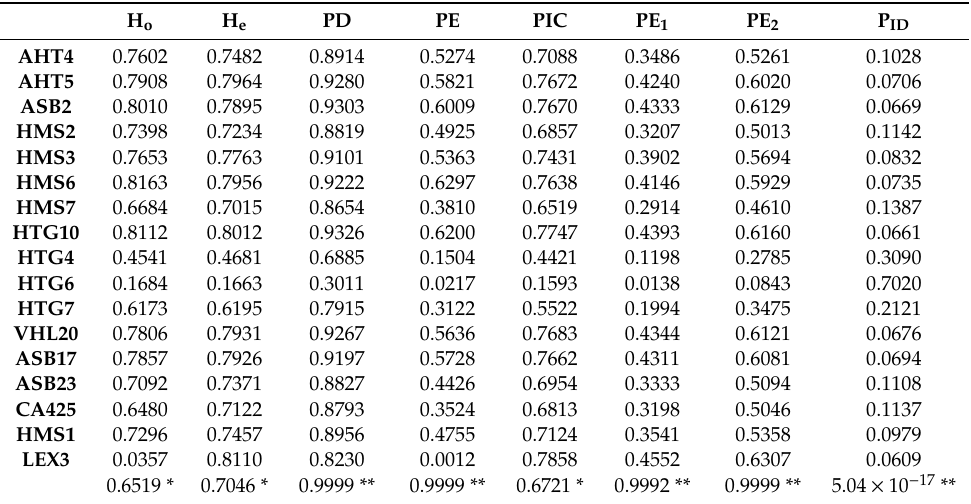
Table 3. Population coe ffi cients for all loci in the 17 microsatellite markers (STR)